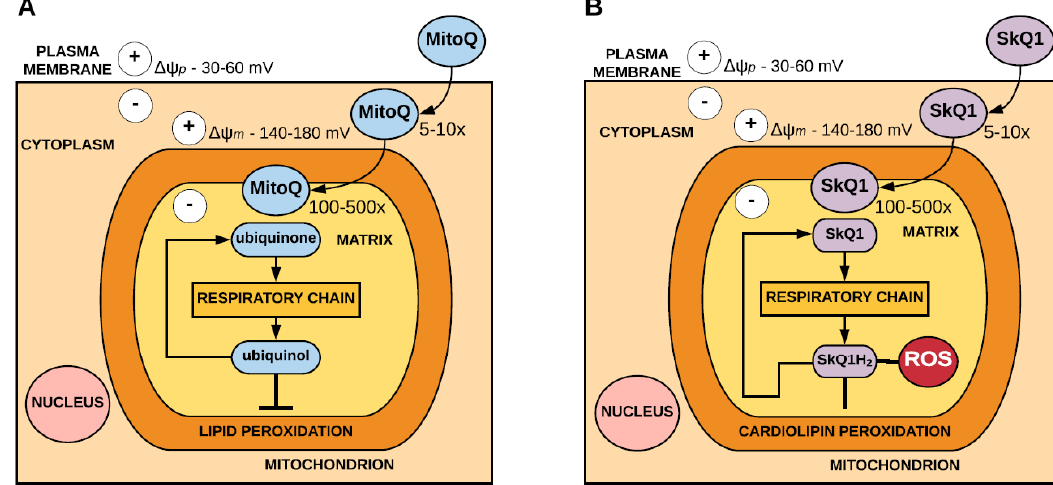
Figure 1. Accumulation and antioxidant mechanism of 10-(4,5-dimethoxy-2-methyl-3,6-dioxo-1,4-cyclohexadien-1-yl)decyl) triphenylphosphonium mesylate (MitoQ) ( A ) and 10- (6′ -plastoquinonyl) decyltriphenylphosphonium (SkQ1) ( B ). Driven by the plasma membrane potential (Δψ p ), MitoQ and SkQ1 pass through the plasma membrane and accumulate 5-10 fold within the cytosol. MitoQ and SkQ1 then accumulate several-hundredfold within the mitochondria driven by the mitochondrial membrane potential (Δψ m ).Within the mitochondria, MitoQ is reduced to ubiquinol and SkQ1 is reduced to SkQH 2 by the respiratory chain. In acting as an antioxidant, ubiquinol is oxidised to ubiquinone and SkQH 2 is oxidised to SkQ1, both of which are rereduced by the respiratory chain. MitoQ is effective at preventing lipid peroxidation. SkQ1 is effective at preventing peroxidation of cardiolipin and inhibits the production of superoxide. (adapted from Murphy and Smith, 2007 [39]).